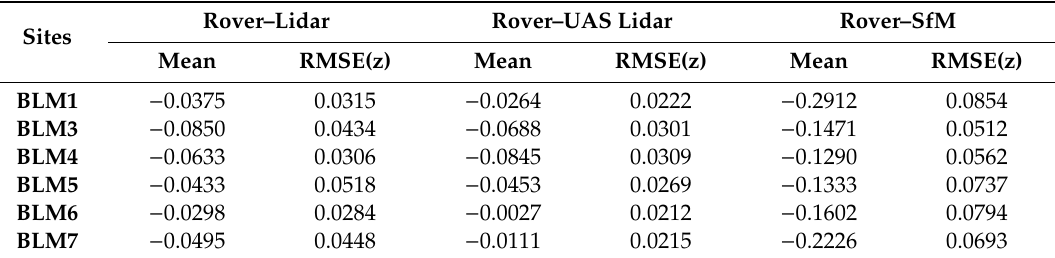
Table 3. VVA analysis results in meters.